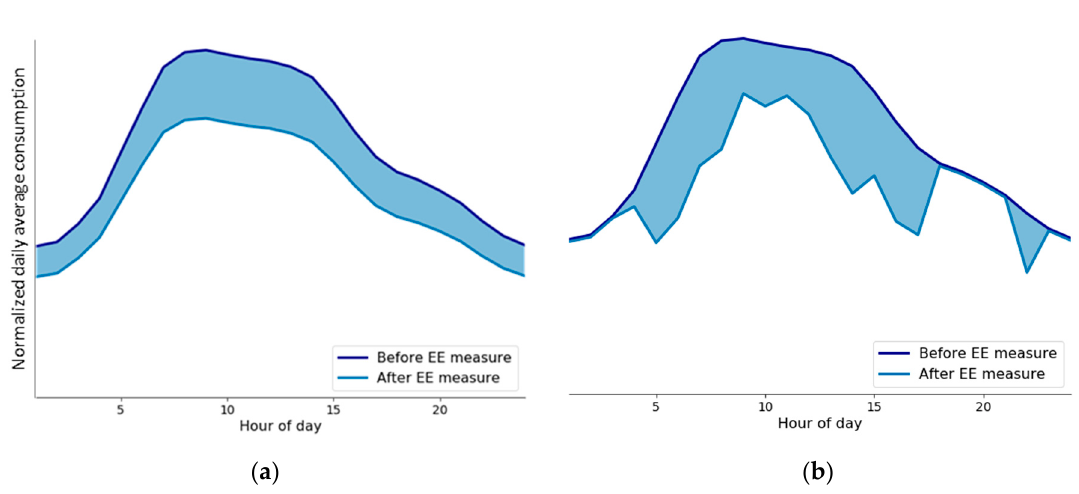
Figure 1. Illustration of normalized load shape pre- and post-investment with similar shape based on commercial efficient lighting example ( a ) and normalized load pre- and post-investment with different shape based on commercial lighting occupancy sensors example ( b ) from data accompanying [25].